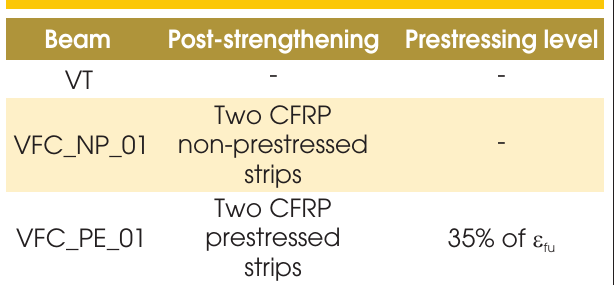
Table 1 – Description of Experimental Program